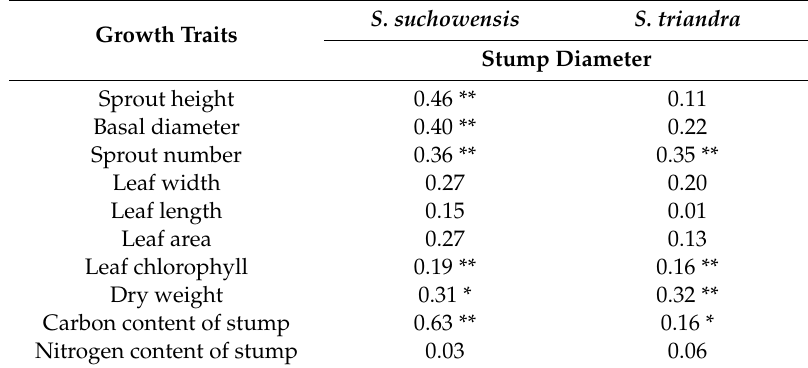
Table 3. Pearson correlation coe ffi cients (r) between stump diameter and growth traits in two willow species.